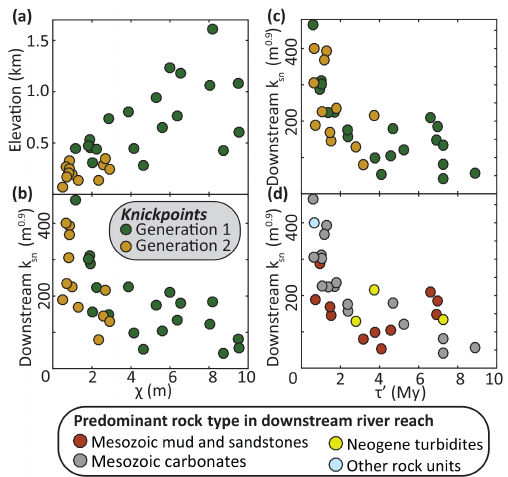
Figure 8. Plots of major knickpoint metrics from trunk channels in south-central Crete. (a) χ versus elevation for generation 1 and 2 knickpoints. The stream power incision model predicts that knick- points from a common origin will remain at the same χ as they travel upstream, provided that n = 1 and erodibility and drainage area are constant in space and time. (b) χ versus k sn for genera- tion 1 and 2 knickpoints. Note that for each generation there is an apparent weak inverse correlation between χ and k sn . (c) τ (cid:48) versus k sn for generation 1 and 2 knickpoints. (d) Same data as c , but each point is colored according to the predominant rock type on the next downstream